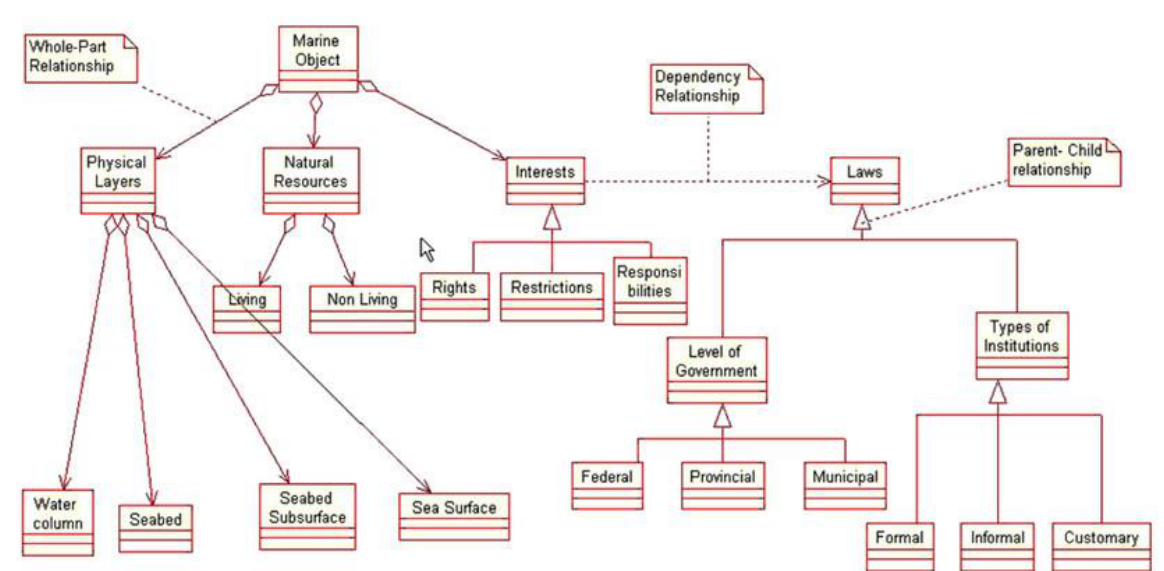
Figure 11. A marine parcel data model. Reprinted from Ref. [49]. Copyright 2014, Ng’ang’a et